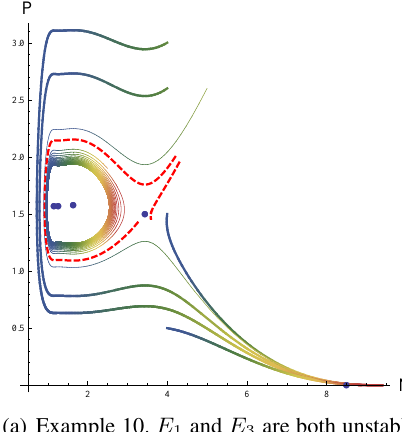
(a) Example 10. E 1 and E 3 are both unstable; the thick dashed line separates the basin of attraction of E K .